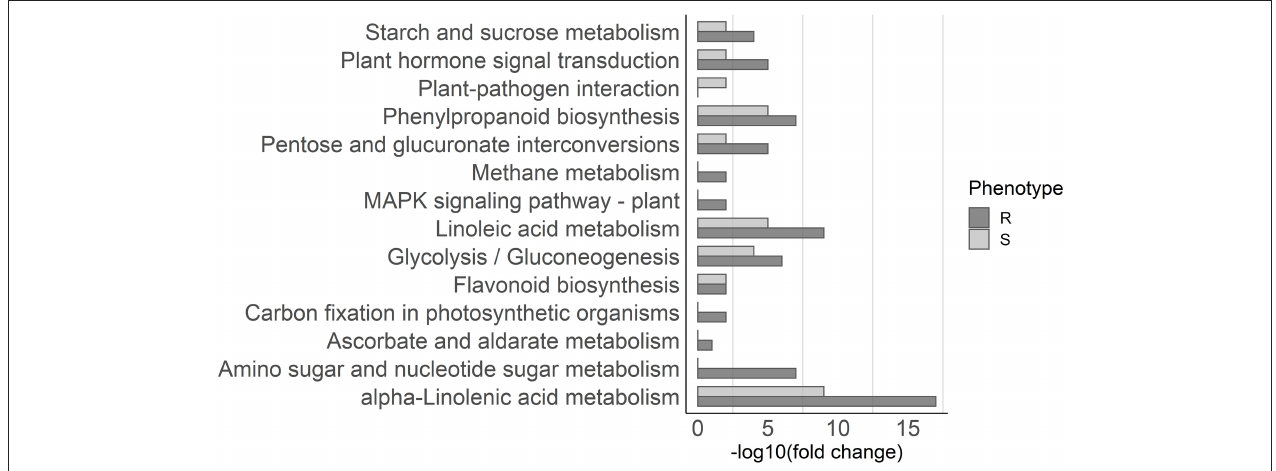
FIGURE 4 | Pathway enrichment analysis. KEGG pathways overrepresented in the upregulated genes in resistant (dark gray) and susceptible (light gray) samples are depicted in the graph. The x-axis represents the significance of KEGG enrichment (–log10 of corrected p -values).